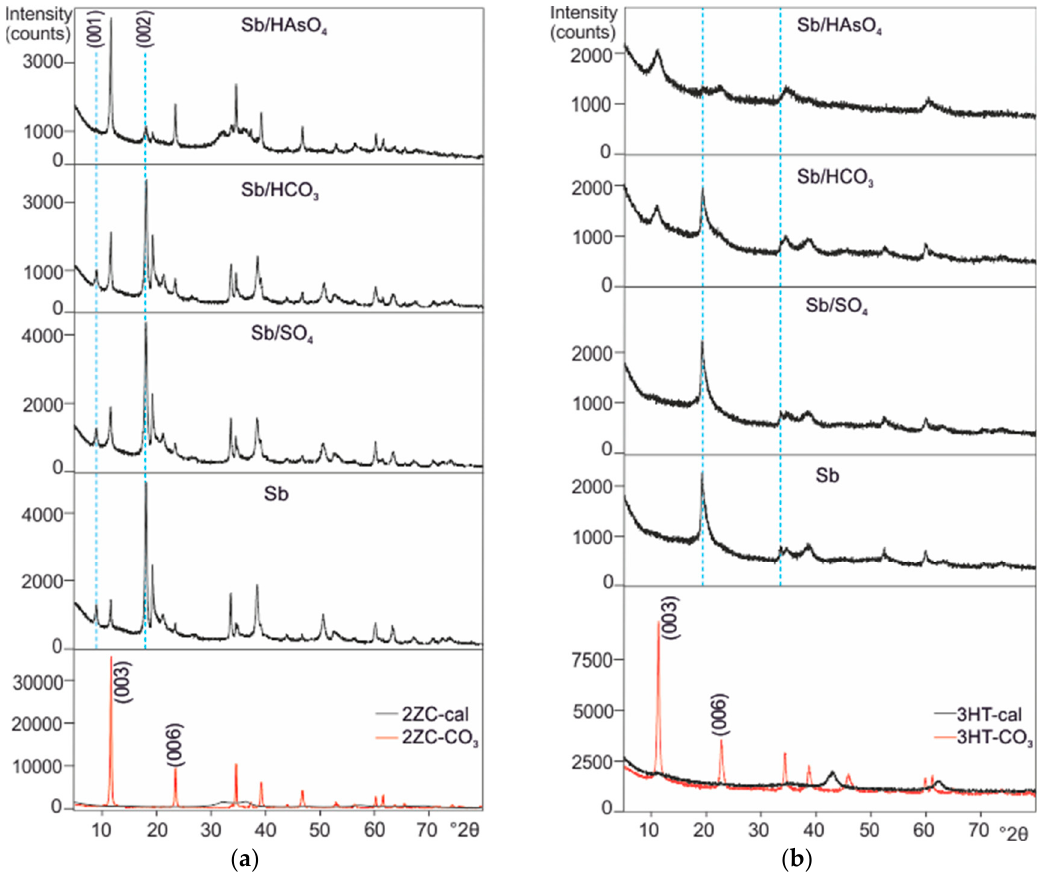
Figure 3. XRD patterns of ( a ) 2ZC-CO 3 and its calcined product 2ZC-cal and of ( b ) 3HT-CO 3 and its calcined product 3HT-cal, and XRD patterns of sorbents recovered after the sorption experiment without competitors (Sb), and with coexistent SO 4 2 − (Sb / SO 4 ), HCO 3 − (Sb / HCO 3 ) or HAsO 4 2 − (Sb / HAsO 4 ). The blue dashed lines indicate the peaks of the ( a ) zincalstibite-like and ( b ) brandholzite-like compounds formed after the sorption experiments.